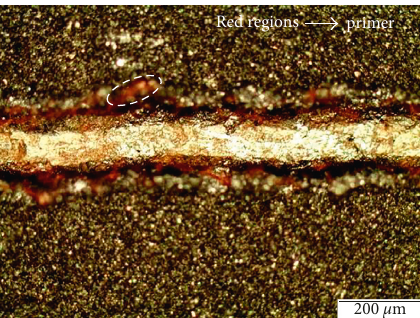
Figure 7: Optical image of a scratched surface of the resin-bonded MoS 2 coating. Red regions represent the basecoat.